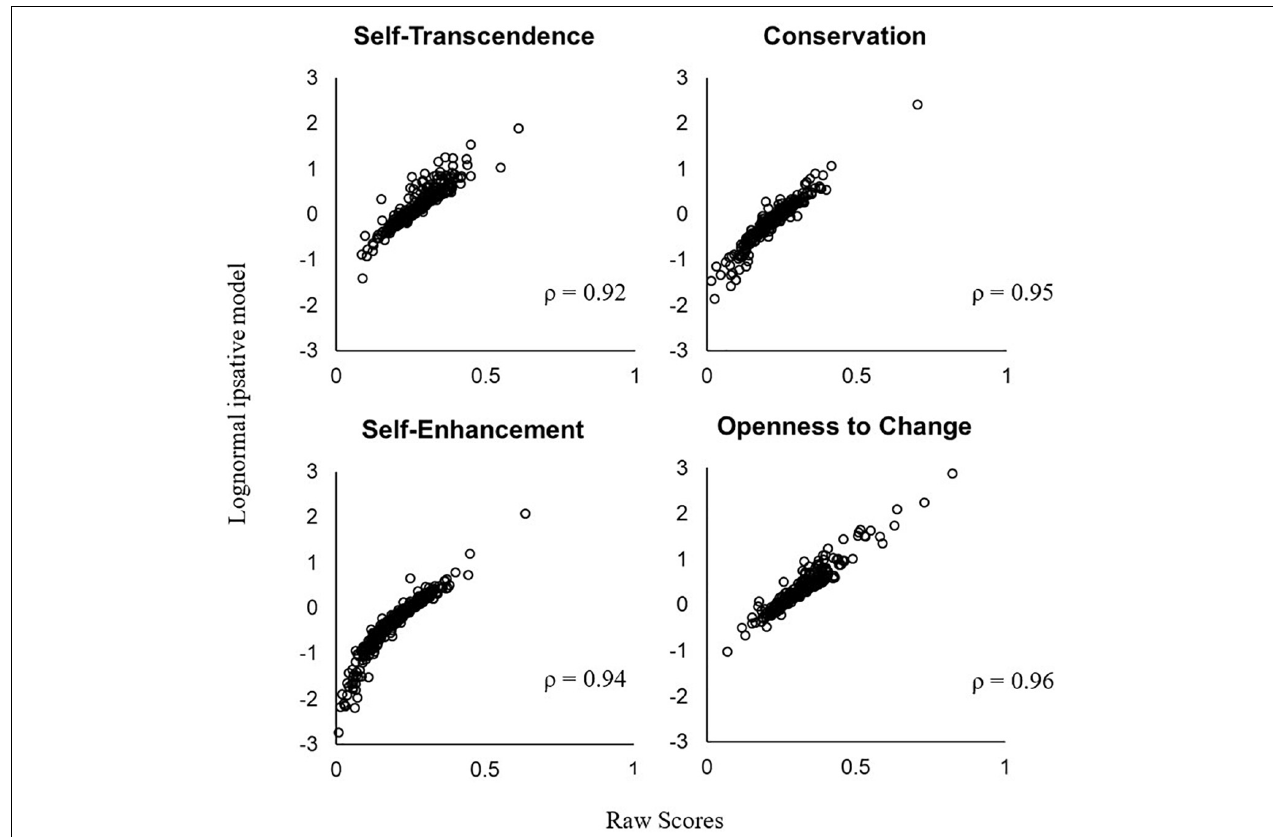
FIGURE 6 | Relationship between a person’s raw score and trait estimate in the lognormal ipsative model.